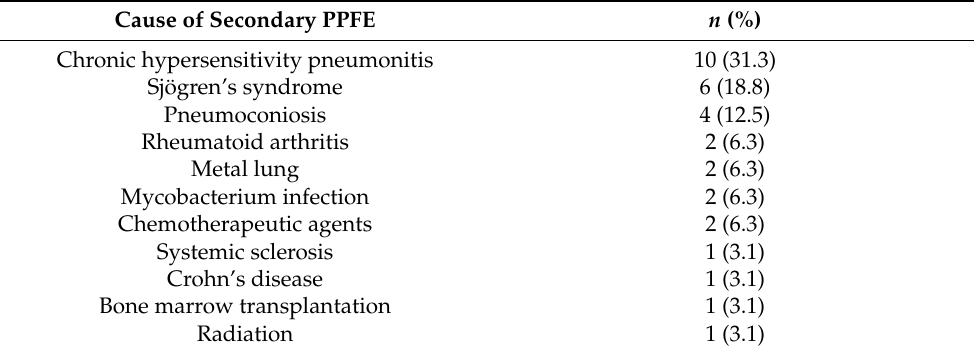
Table 1. Data presenting proven causes of secondary PPFE.